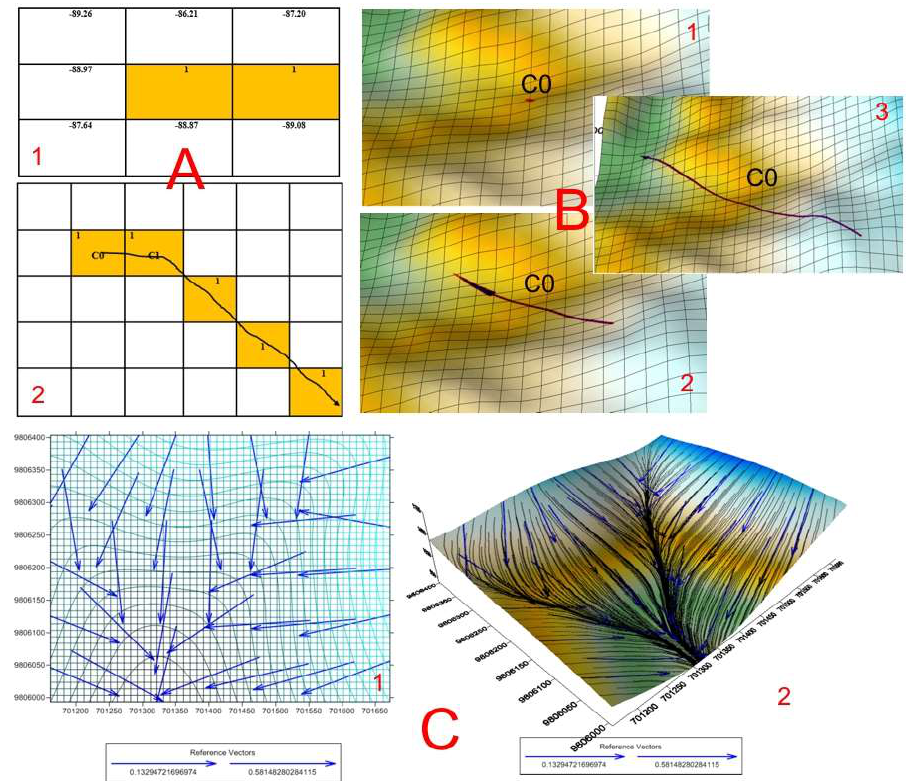
Figure 5. ( A1 , A2 ) Operation of the propagation rule. The cell with the maximum negative slope is the cell that will change status from 0 (off) to 1 (on) as shown in yellow. ( B1 ) The center of cell C0 is the start of the drawing of the flow lines. ( B2 ) Drawing the flow line “downstream”. ( B3 ) The final plot of the flow line upstream and downstream from starting cell C0. ( C1 ) Plotting the flow lines of surface-water runoff from the elevation mesh of the DEM and ( C2 ) concentration in drainage channels and erosion of geoforms.